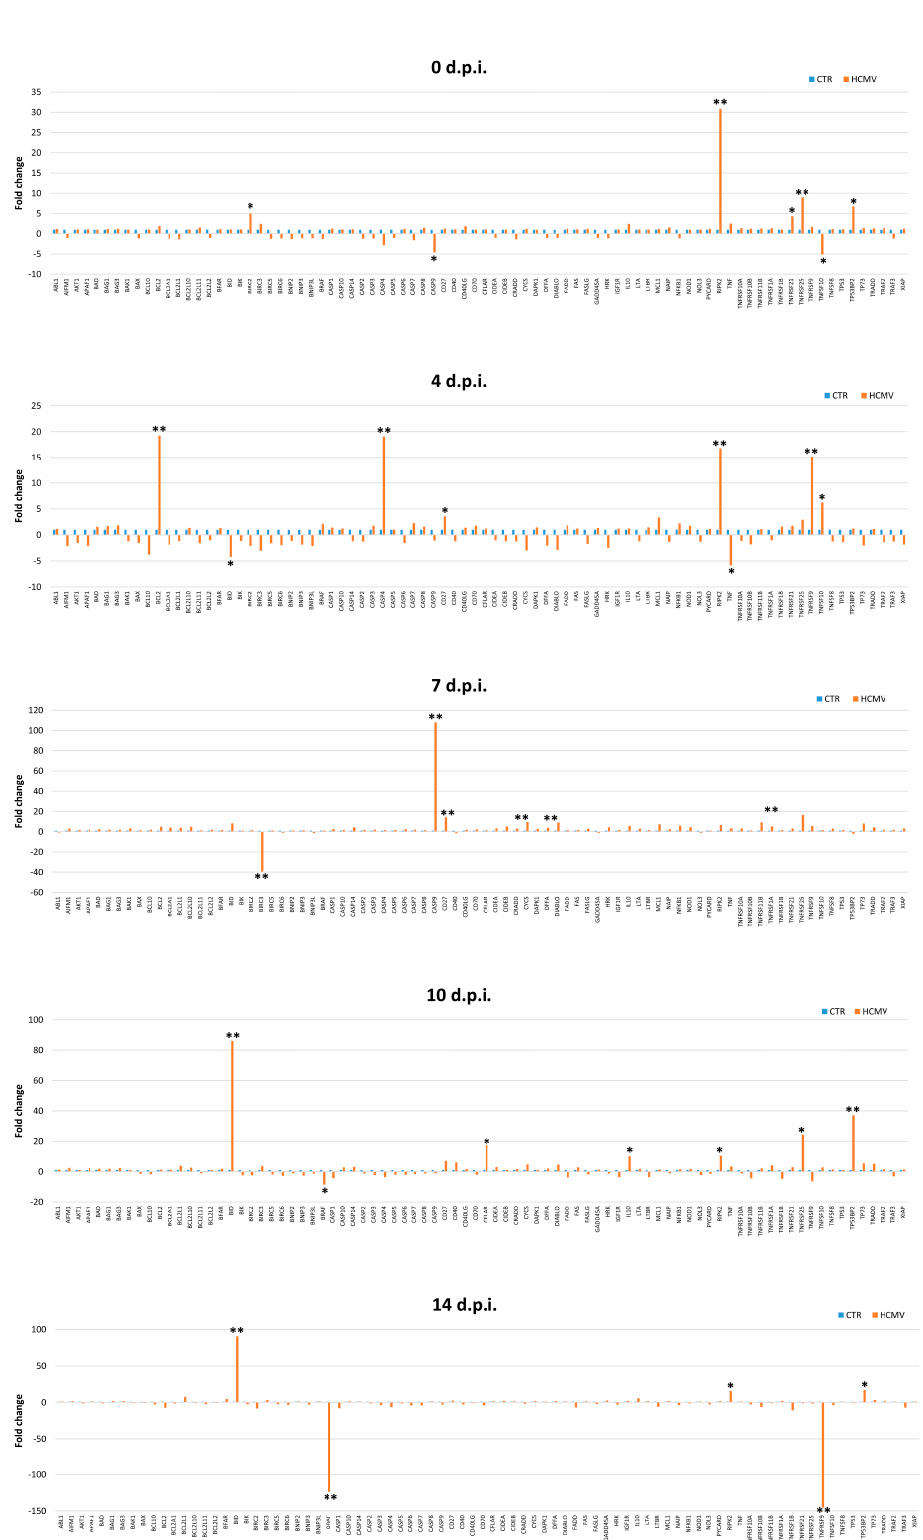
Figure 6. Expression of the apoptosis-associated factors altered by human cytomegalovirus (HCMV) infection in primary human dermal fibroblasts. At each time p.i. (d.p.i. = days post-infection), cell samples were collected and analyzed by specific qPCR microarray. Results are expressed as mean values of fold change (infected cells vs. controls) ± SD of duplicate samples from two independent experiments. * pc < 0.01; ** pc <